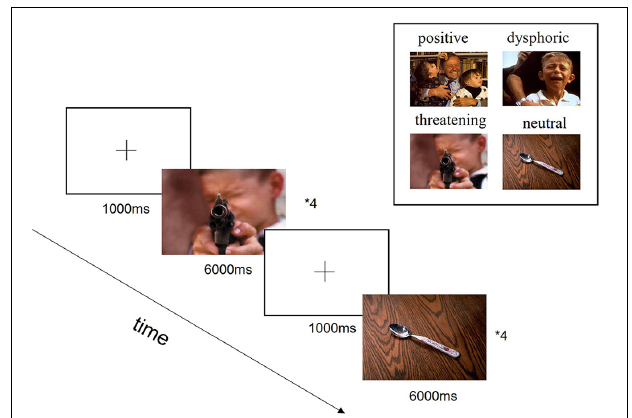
FIGURE 1 | Experimental design diagram. In the beginning, each trial was presented a fixation cross in the center of the screen for 1,000 ms, followed by the presentation of stimuli for 6,000 ms. Each block contained four trials with specific emotions and four trials with neutral images. The aim of the neutral images added was to confuse the experimental purpose and reduce subjects to guess the experimental intention, which would affect the collected data. A total of 9 blocks were presented in a pseudo-randomized